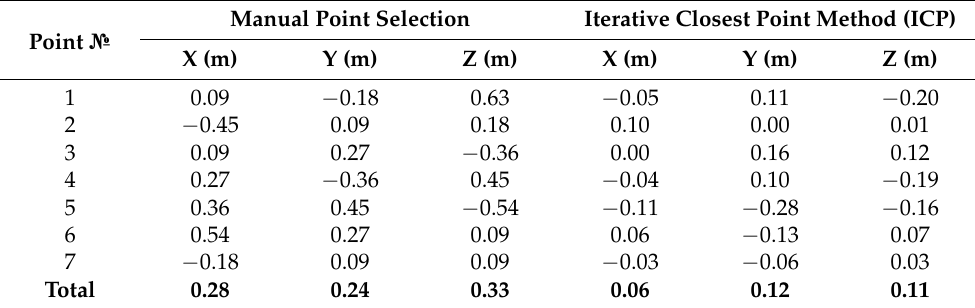
Table 3. Point clouds georeferencing errors for Site